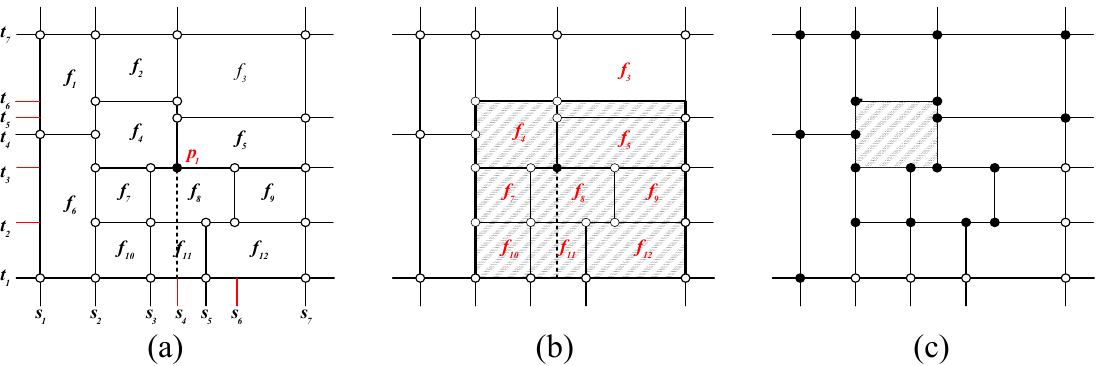
Figure 1. Knot vectors calculation, influence domain, influence points of T-spline surface: ( a ) Knot vectors calculation of control points using the ray intersection method, ( b ) the influence domain of a control point filled with shaded area, ( c ) a set of control points marked by a solid circle for one shaded face.